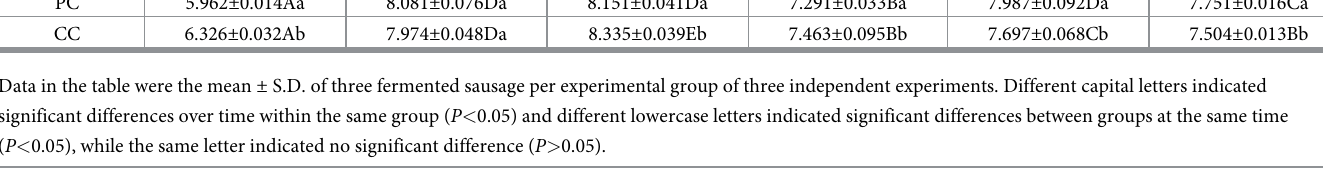
Table 3. The change in lactic acid bacteria number during processing and storage period.